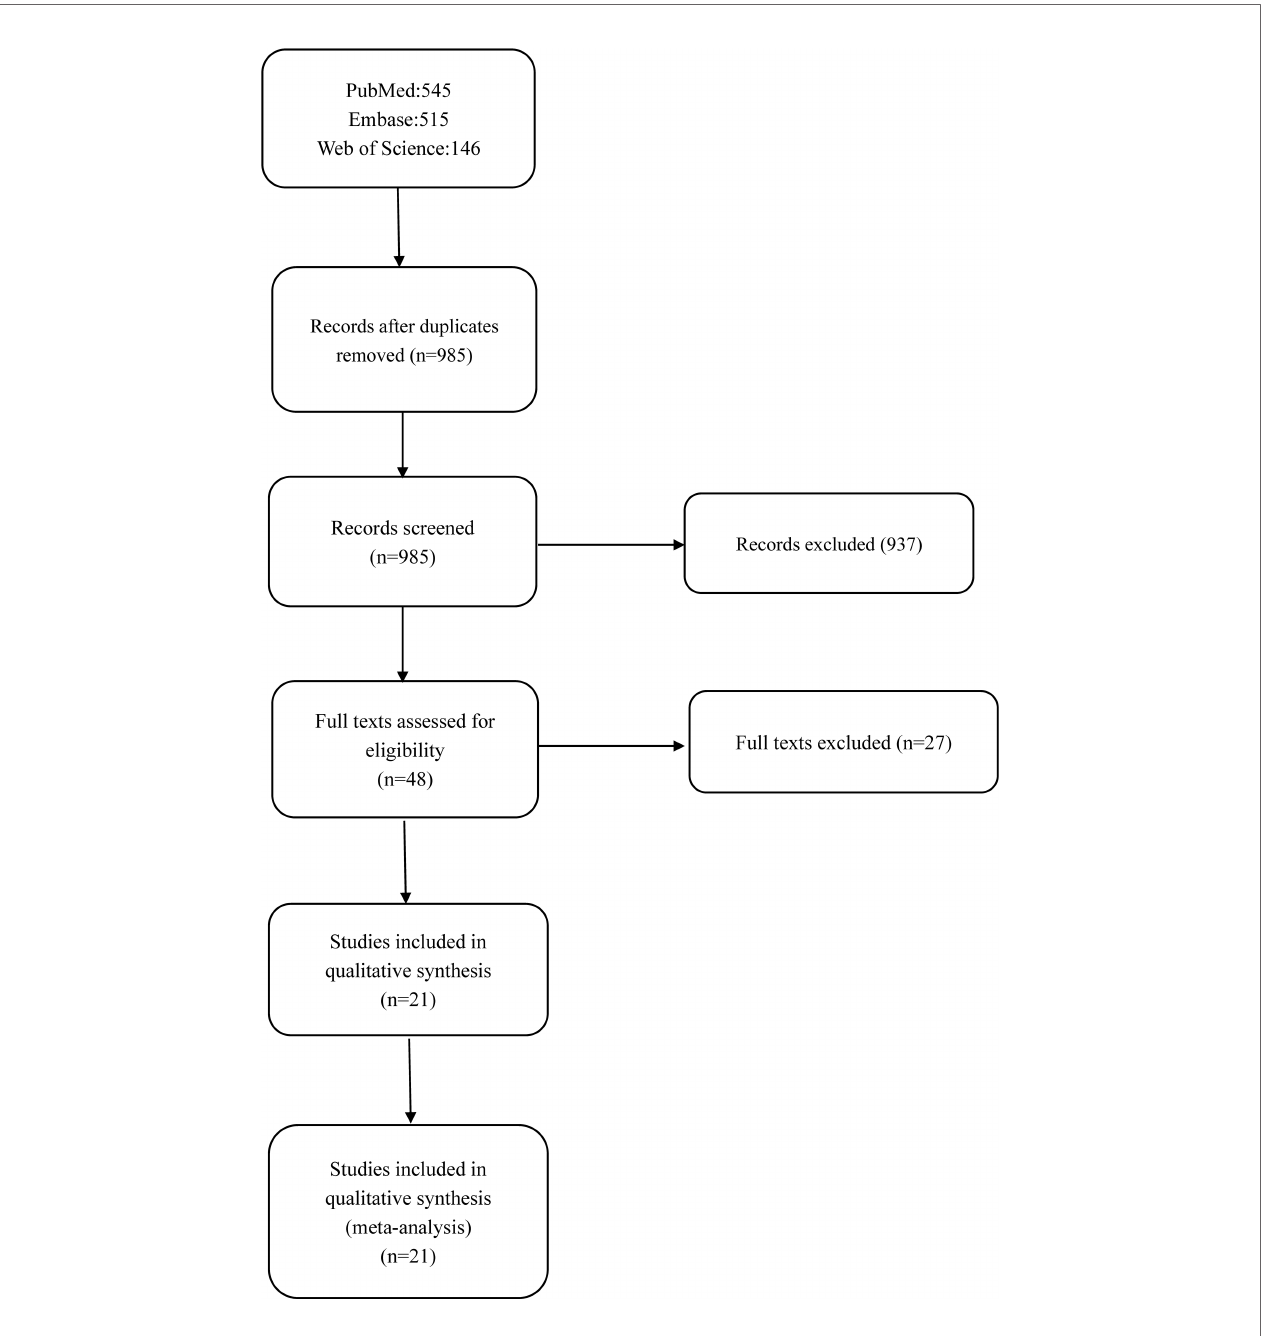
FIGURE 1 | Flow diagram of studies